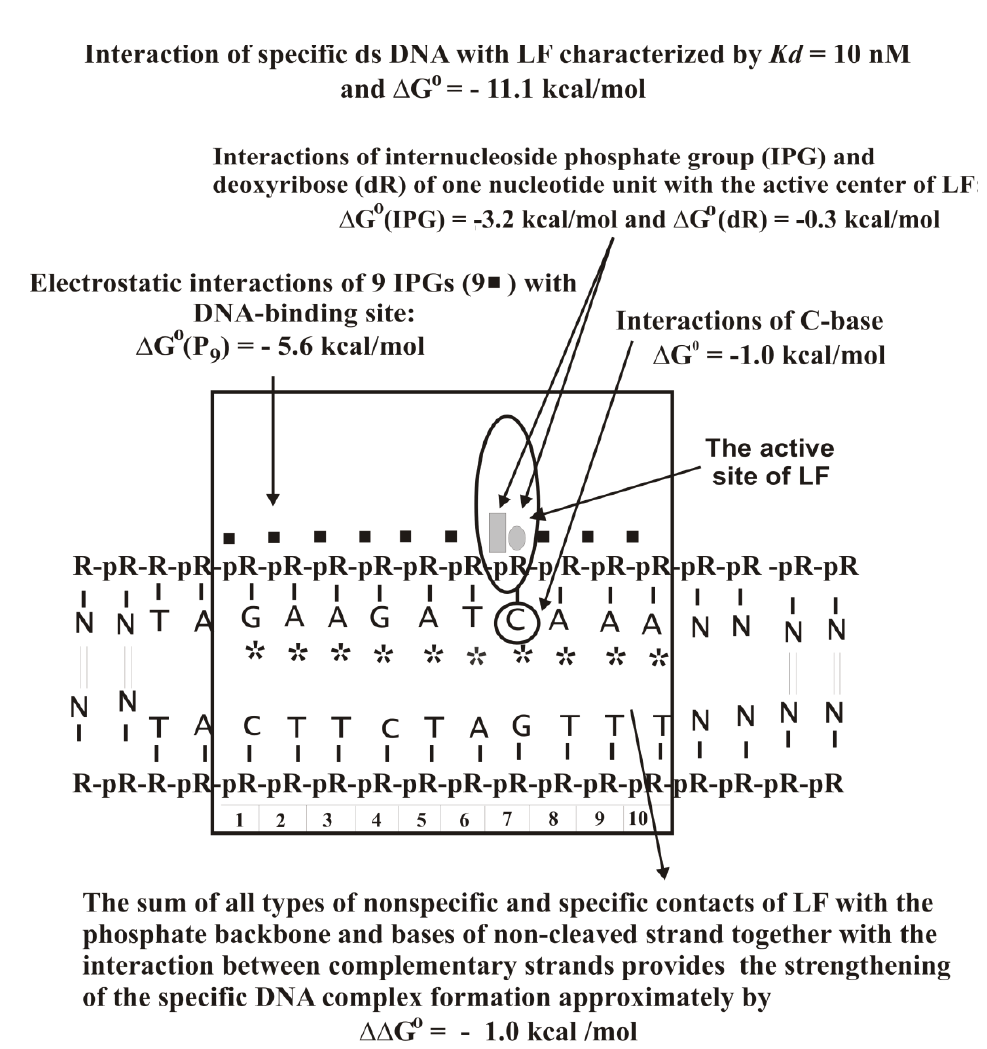
Figure 17. Thermodynamic model of human lactoferrin interaction with specific oligonucleotide. ∆ G ◦ values characterizing various contacts between the protein and DNA are shown [124].